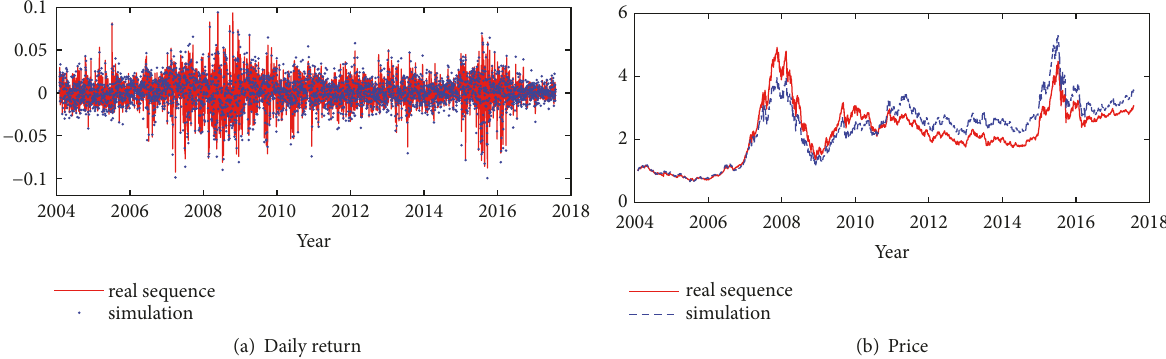
Figure 3: The best simulation and the real stock data sequence. The red curve is the real data and the blue one is the simulated sequence of CSI300 Index from Jan 1 𝑠𝑡 2004 to Jun 30 𝑡ℎ 2017. Panels (a) and (b), respectively, show the daily return and price simulations, and the starting point of the price is set to be 1.